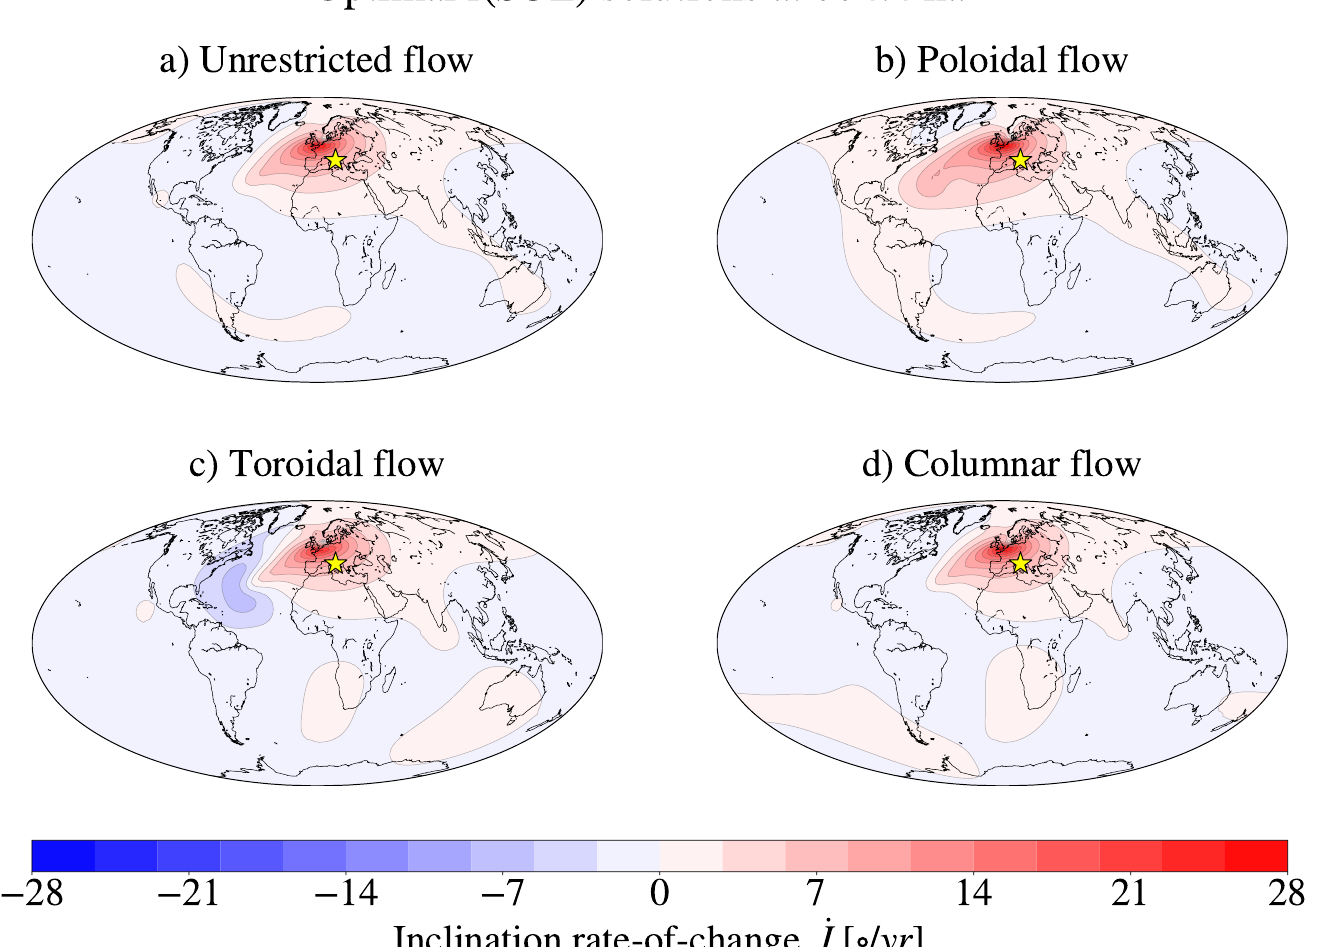
Figure 10. Rate of change of inclination, driven by flows (the geometry of which is indicated in the figure) that optimise ˙ I ( SUL ) at 774.4 ka for a value of T ˙ I ( SUL ) = 8.6 ◦ /y at the SUL location 0 that is required to reproduce the SUL16 value of (marked by the yellow